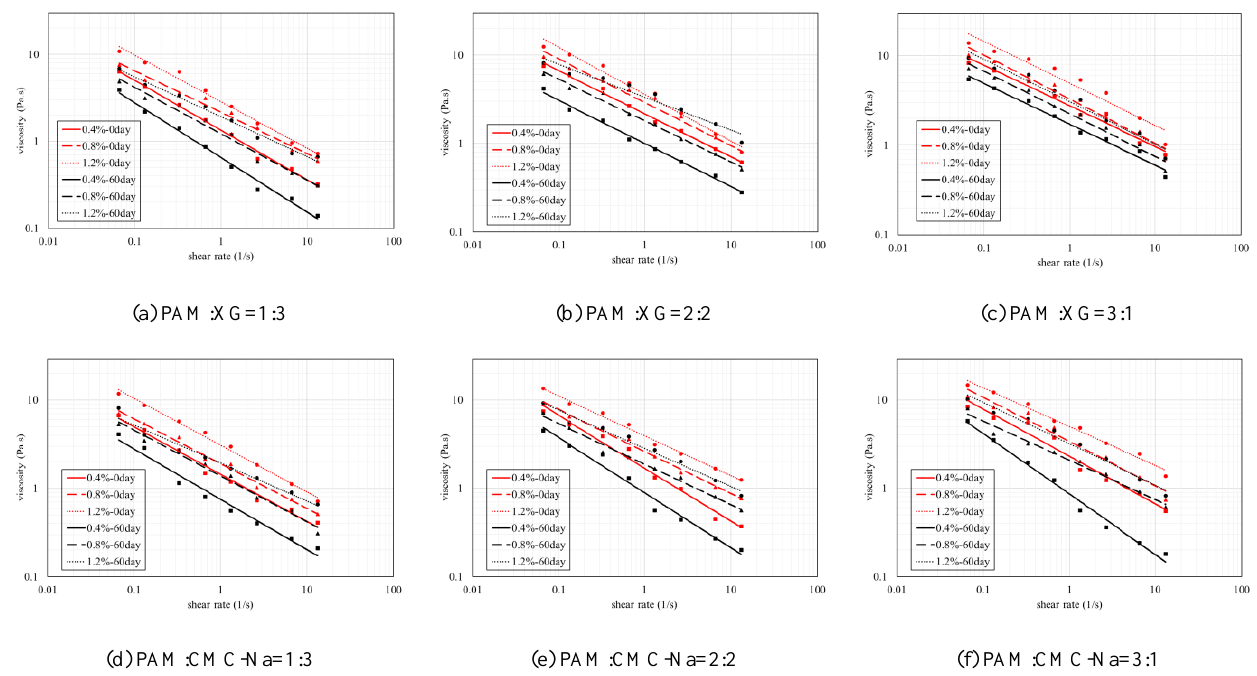
Figure 6. Dynamic viscosity of polymer mixtures at different aging times. Table 2. Improve rate of dynamic viscosity at different aging times. PAM:XG